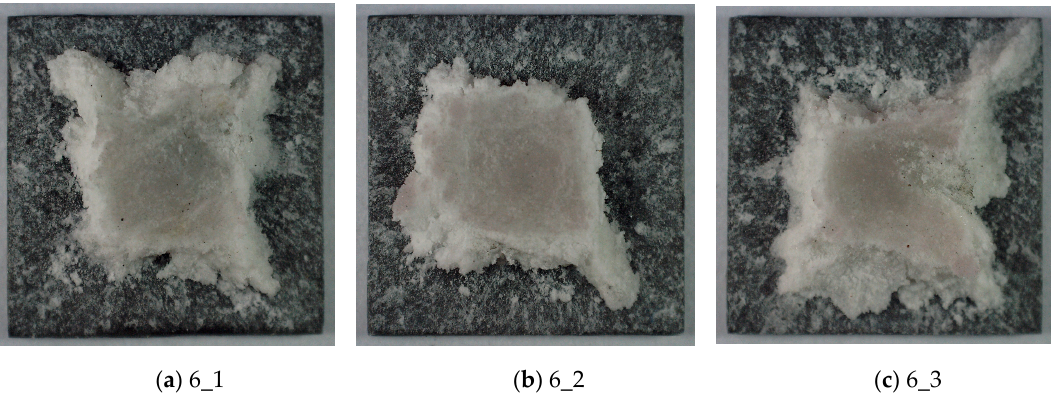
Figure 12. The TBC ceramic mats of samples after compressive impact the tests at 90 °C. ( a ) sample 6_1 ( b ) sample 6_2 ( c ) sample 6_3.